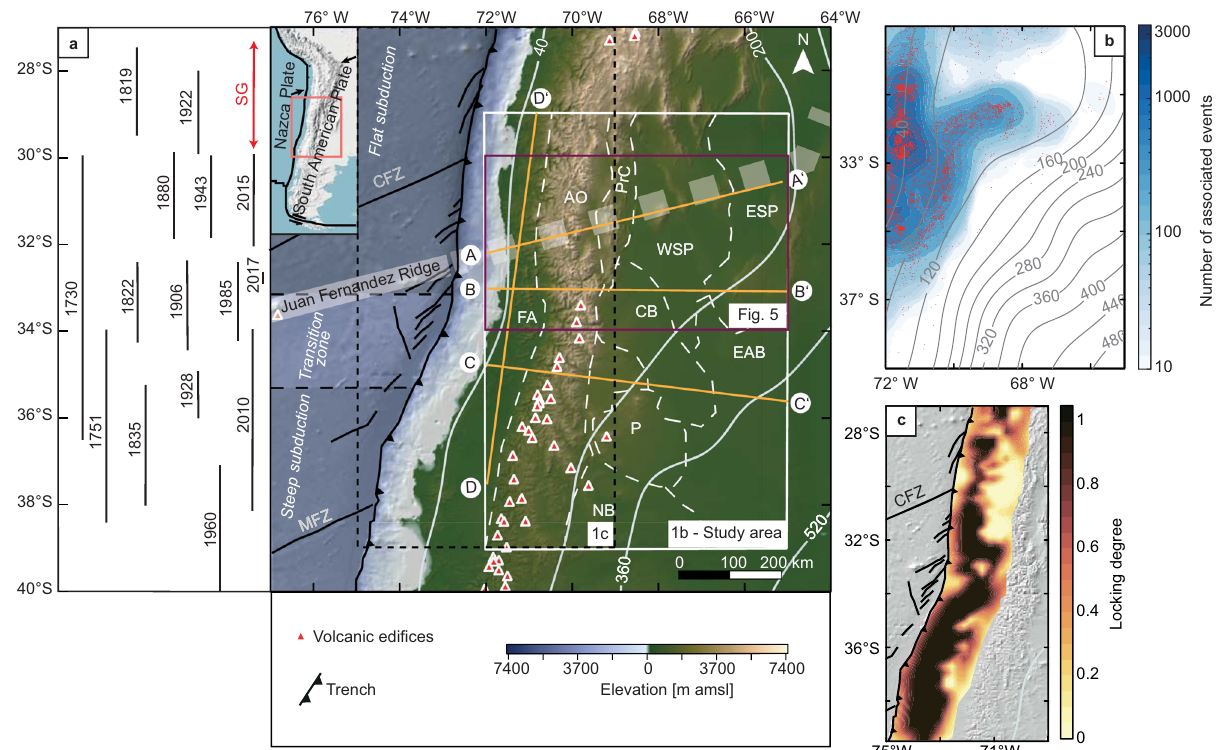
Fig. 1 The southern Central Andes and distribution of slab seismicity. a Main panel: topography and bathymetry of the southern Central Andes based on the ETOPO1 global relief model 89 . The white rectangle encloses the extent of the area considered in this study (area of Fig. 1b); the black dashed rectangle encloses the area shown in Fig. 1c; the purple rectangle encloses the area shown in Fig. 5. Black-dashed lines in the oceanic domain mark the boundaries between subduction segments ( fl at slab in the north, steep slab in the south). Fracture zones of the Nazca Plate 75 are highlighted by solid black lines. Abbreviations of main fracture zones: MFZ = Mocha Fracture Zone; CFZ = Challenger Fracture Zone. White lines show the isobath contours (km below mean sea level) of top of the slab (based on the Slab2 model 75 ). The wide transparent white line denotes the position of offshore (full line) and projected onshore (dashed line) tracks of the Juan Fernandez Ridge (JFR) 90 . The red triangles depict locations of active volcanoes 91 . The orange lines denote locations of pro fi les shown in Fig. 2. The boundaries between the main morphotectonic provinces are shown by white dashed lines. Abbreviations of main tectonic provinces: AO Andean orogen, CB Cuyo Basin, ESP Eastern Sierras Pampeanas, EAB extra-Andean basins, FA forearc, NB Neuquén Basin, P Payenia volcanic province, Prc Precordillera, WSP Western Sierras Pampeanas. Left panel: extent of historical seismic ruptures 92 . Seismic gaps (SG) are shown with red lines. b Seismic-event density (logarithmic scale) derived for a circular bin of 75 km radius for slab seismicity 21 . Seismicity marked by red dots. Isobath contours of the top of the slab are drawn in grey. c Degree of locking of the subduction interface 67